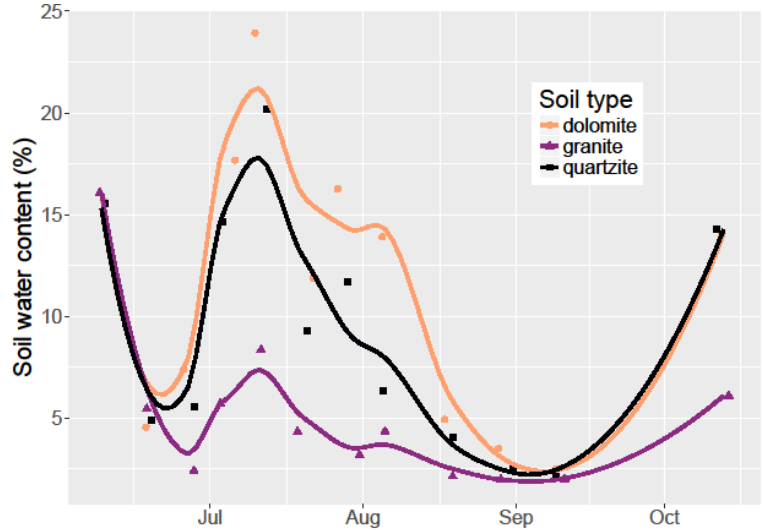
Figure 3. Measured soil water content over the course of the 2015 growing season. Each point is a mean of the 12 containers for each soil type. Lines were drawn using local regression (LOESS) smoothing with a span of 0.5.